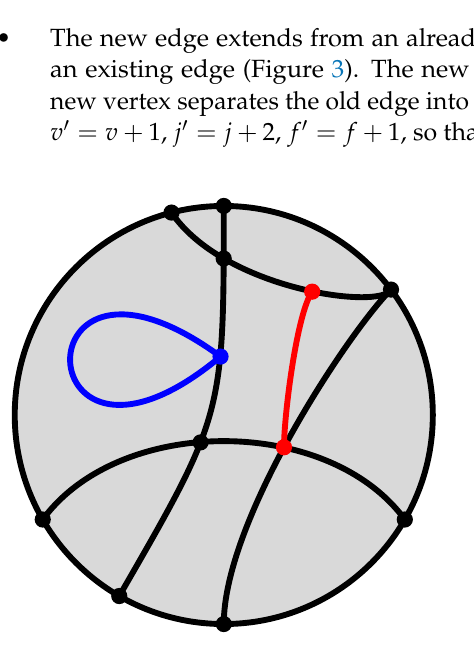
Figure 2. The red edge starts and ends at the same vertex, while the blue one belongs between two vertices.